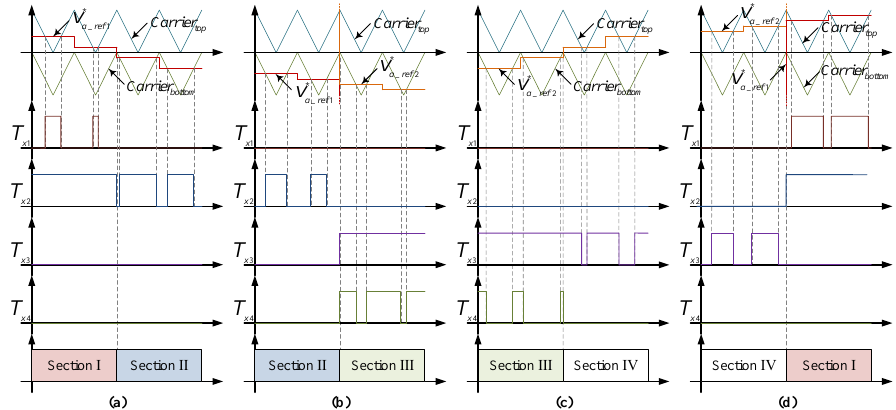
Figure 10. Switching state of proposed ZDPWM when transition of section: ( a ) from I to II; ( b ) from II to III; ( c ) from III to IV; ( d ) from IV to I.